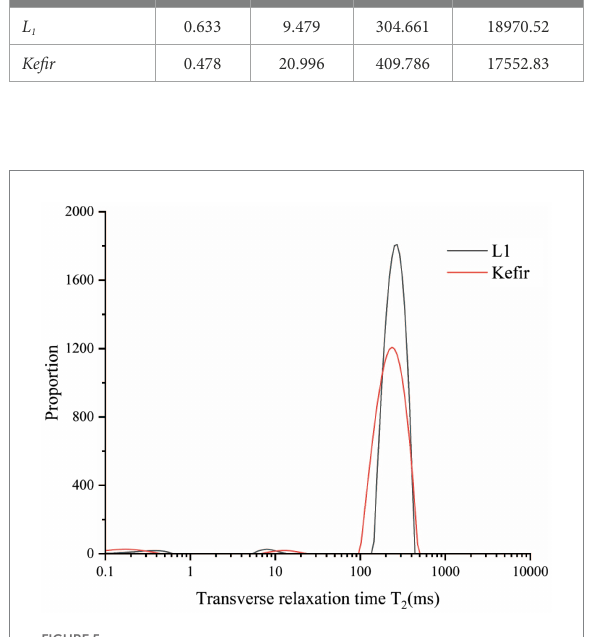
FIGURE 5 Distribution of T 2 relaxation times on set yoghurts at L 1 and kefir by LF-NMR.